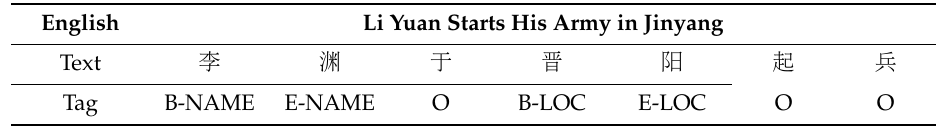
Table 2. An example of Chinese ancient historical text named entity annotation, Example “ 李 渊 于 晋 阳 起 兵 (means: Li Yuan starts his army in Jinyang)”, where Li Yuan is a person’s name and Jinyang is a place name.